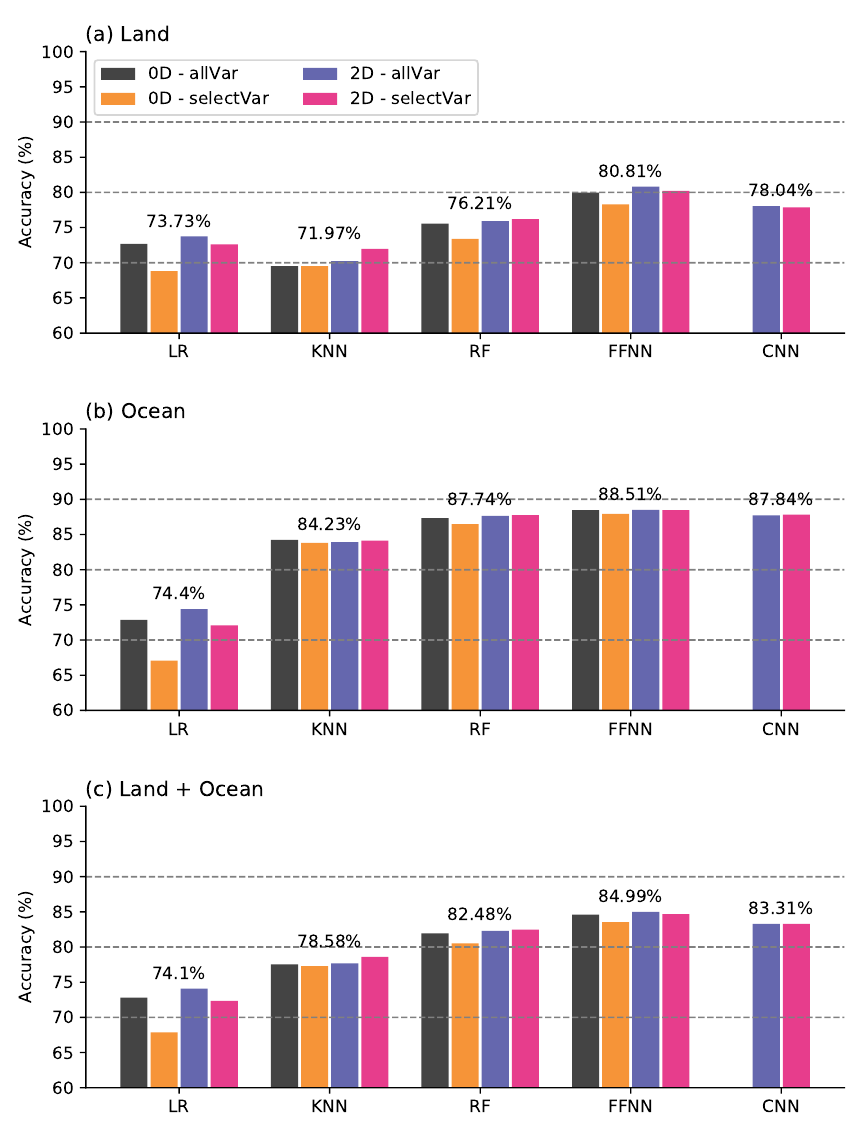
Figure 3. Accuracy of five different ML based models with different structures of predictor variables. Accuracy is calculated as total number of correct predictions (both clear sky and dust) divided by total number of test dataset. Accuracy plotted on top of each bar represents the highest accuracy among the different structures of predictor variables, for each of the methods. ( a ) Land; ( b ) Ocean; ( c ) Land +